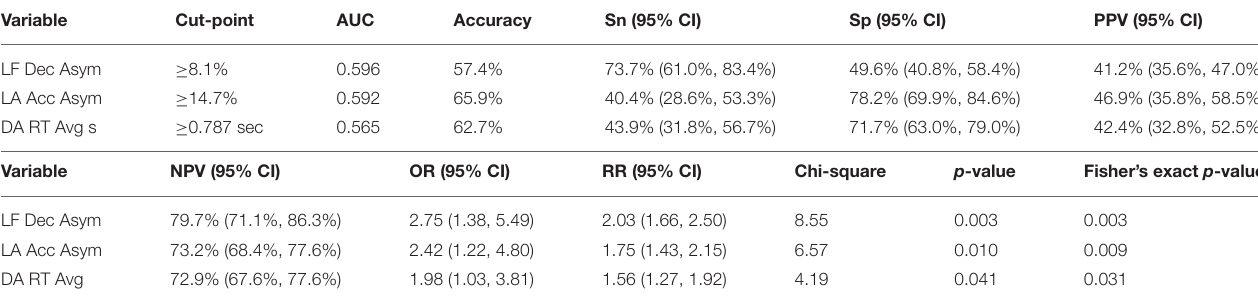
TABLE 5 | 2 × 2 cross-tabulations output for final three binary variables in the prediction model. Variable